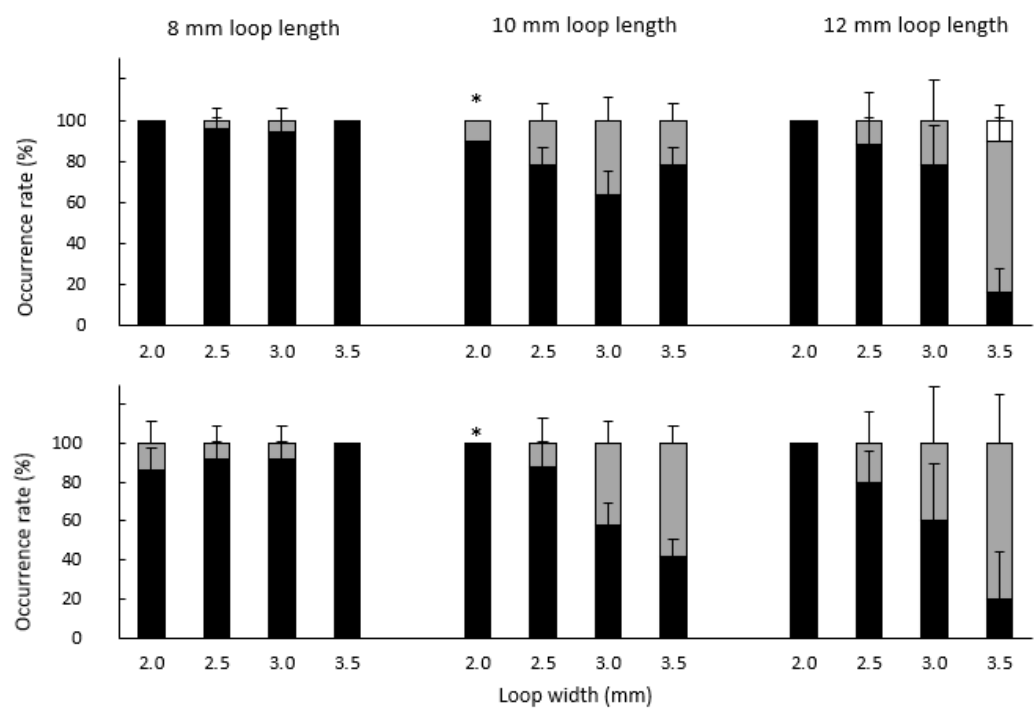
Figure 6. Occurrence rate of vitrification outcomes for different loop widths and lengths of VDCV with axial supports held horizontally ( upper ) and vertically ( bottom ). Error bars represent the standard deviation. Asterisks indicate significant differences in full vitrification between the horizonal and vertical orientations.